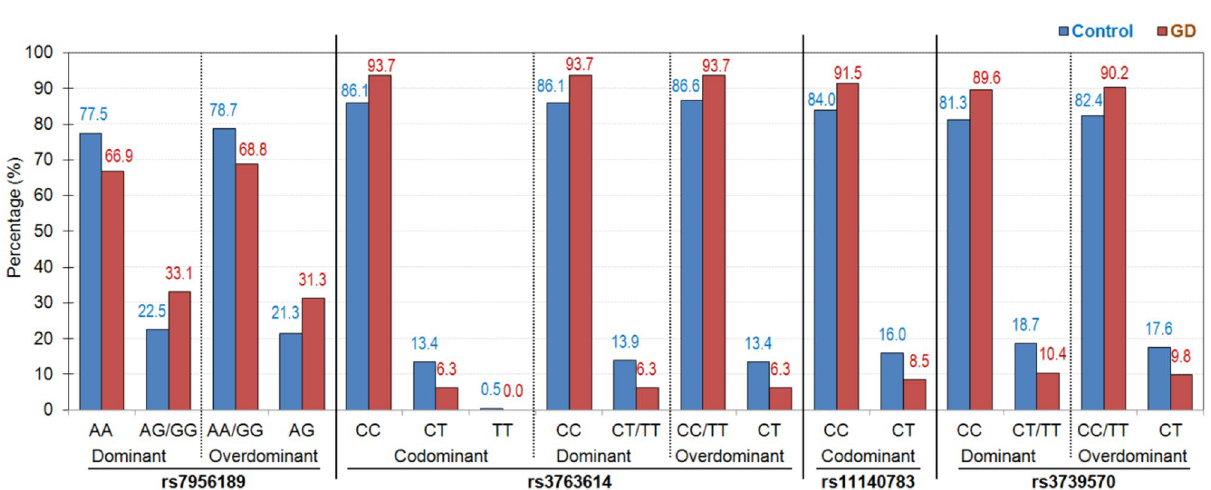
Figure 2. Single nucleotide polymorphism under different genetic models achieving risk for the presence of